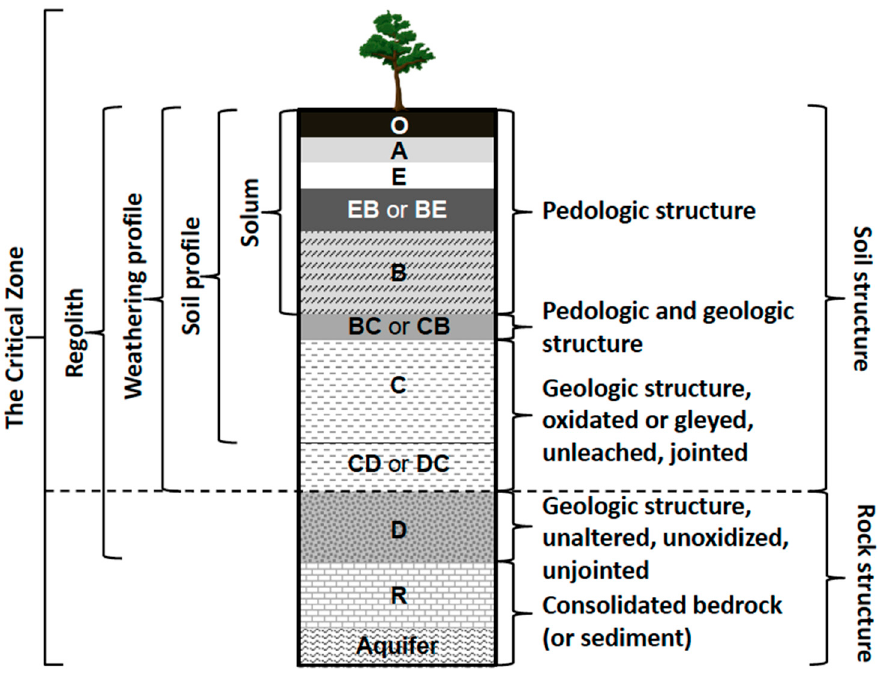
Figure 1. Critical Zone Concept modified from [35]. The D horizon is the unmodified, unweathered part of the C horizon [36]. Transportable material above fresh unweathered bedrock is called regolith [37].